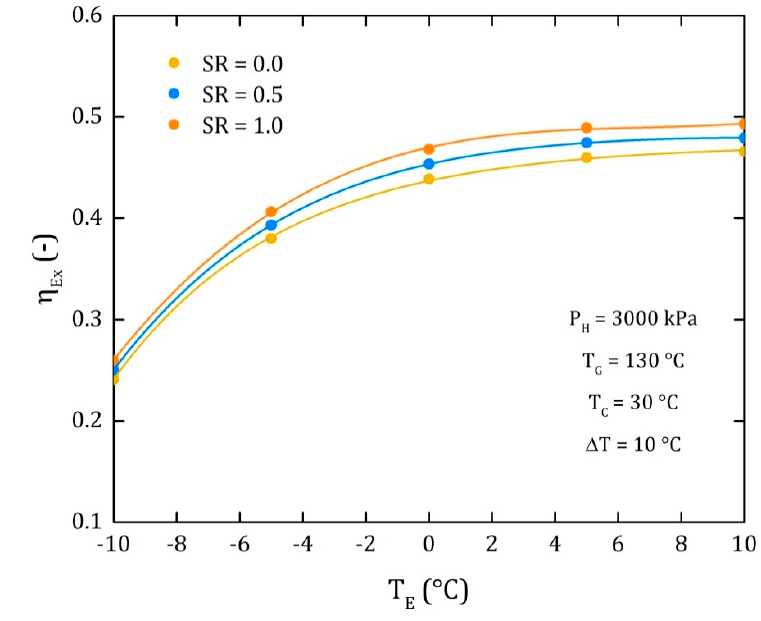
Figure 11. η EX as a function of T E for Model III at three di ff erent values of Figure 11. η (cid:2889)(cid:2908) as a function of T E for Model III at three different values of SR.